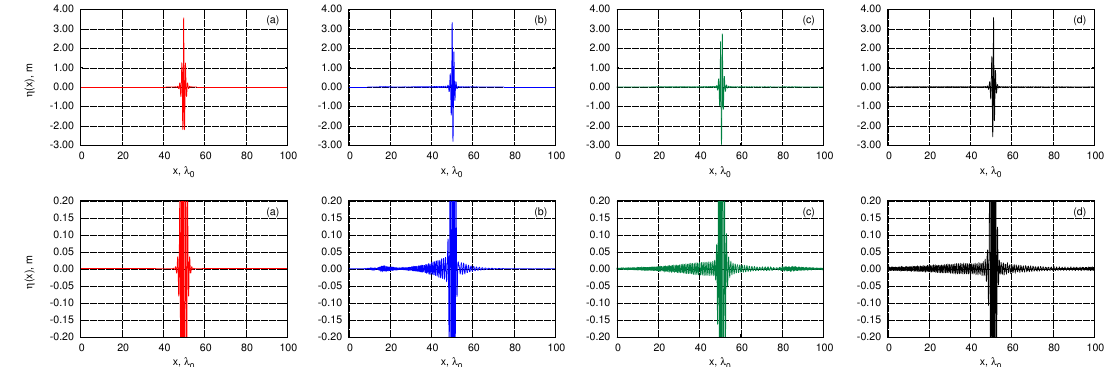
Figure 3. Propagation of single breather with the wave steepness µ ≈ 0.25 in the fully nonlinear model. The initial condition in physical variables was restored with the third order accuracy from variables of the Zakharov equation. ( Top ) row: the surface elevation η ( x ) at different subsequent moments of time. Panel ( a ) shows the initial surface profile (at t = 0); panel ( b ) corresponds to t = 1067 s ≈ 133.3 T 0 ; panel ( c ) corresponds to t = 2134 s ≈ 266.6 T 0 ; and panel ( d ) corresponds to t = 3201 s ≈ 400 T 0 ( Bottom ) row: zoom of the top row